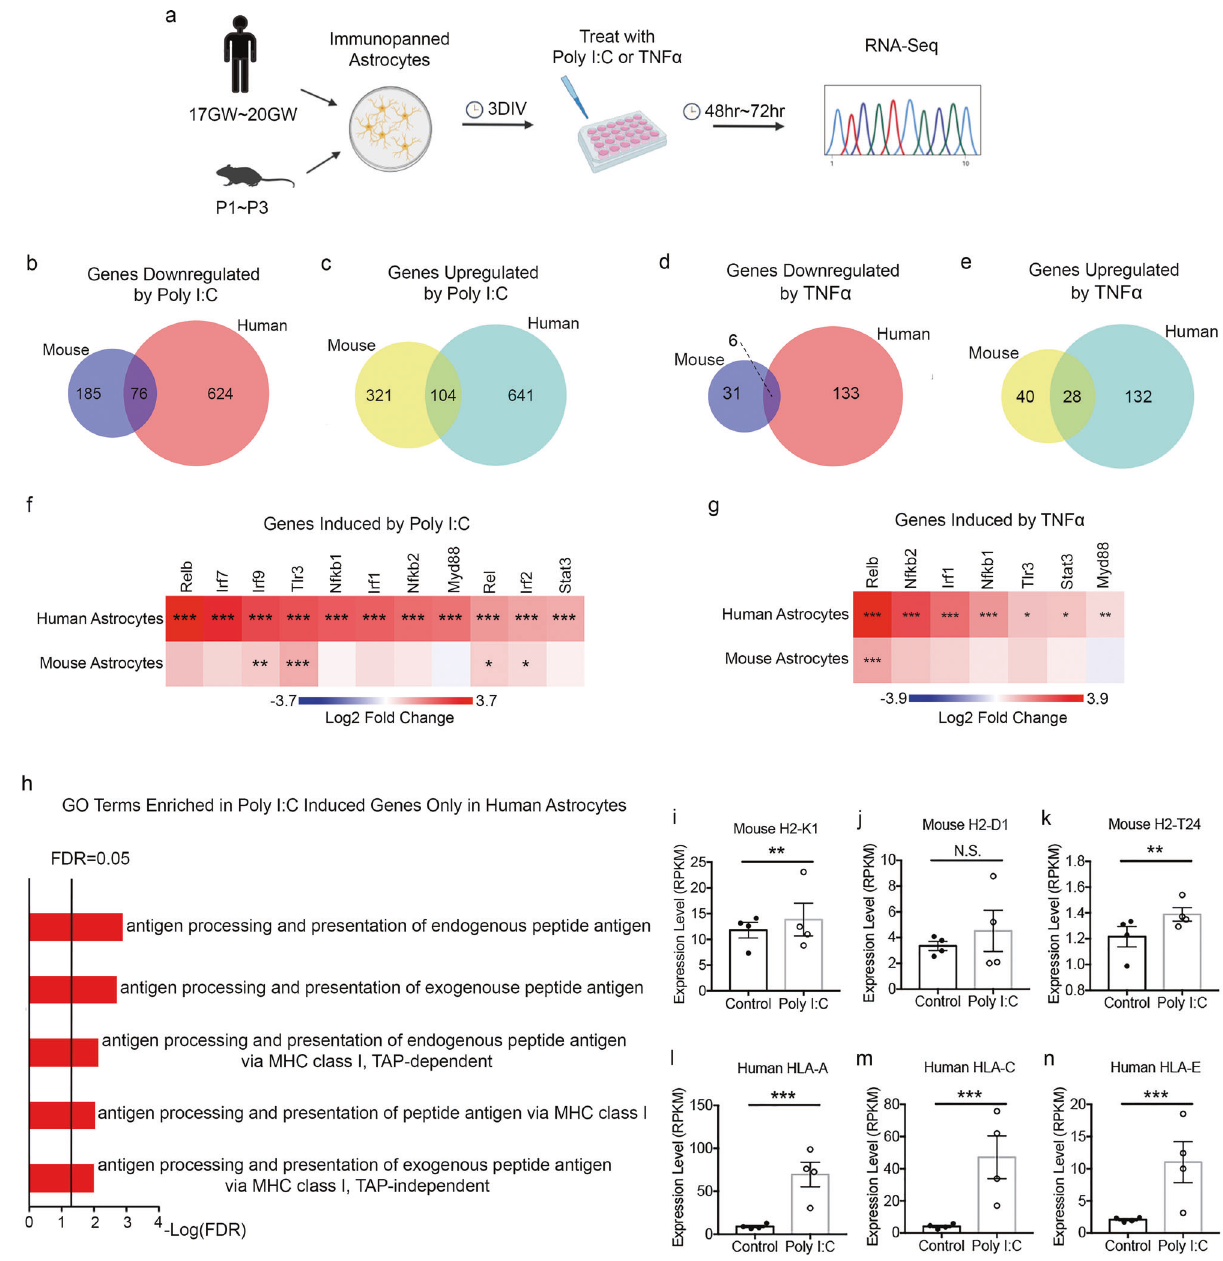
Fig. 7 Molecular responses of human and mouse astrocytes to poly I:C and TNF α . a Experimental design. b – e The number of signi fi cantly up or downregulated genes in poly I:C- and TNF α -treated human and mouse astrocytes. Genes with FDR < 0.05, fold change > 1.5, and average RPKM of control or treated groups > 1 are shown. f , g Fold changes of Tlr3, NF κ B , and interferon response pathway genes in poly I:C- and TNF α -treated human and mouse astrocytes. Asterisks represent signi fi cance determined by DESeq2. h Selected antigen presentation-related GO terms enriched in poly I:C-induced genes only in human astrocytes. i – n Expression of the top 3 highest-expressing MHC Class I antigen presentation genes in poly I:C-treated and control human and mouse astrocytes. N = 4 litters of mice and 4 human patients. Mouse: H2-K1, p = 0.0051; H2-T24, p = 0.0019. Human: HLA-A, p < 0.0001; HLA-C, p < 0.0001; HLA-E, p < 0.0001. Multiple comparison-adjusted p values were calculated by the DESeq2 package. N.S., not signi fi hypoxia, we found that both poly I:C and TNF α induced stronger mouse astrocytes and a signi fi cant proportion (14.0%; 104 out of molecular responses in human astrocytes relative to mouse 745) of upregulated genes in human astrocytes were also astrocytes in terms of the number of differentially expressed genes upregulated in mouse astrocytes under poly I:C treatment (Fig. 7b, c; (Fig. 7b-e and Supplementary Fig. 17a, b, d, e) and effect size upregulated: 1.7-fold higher than expected by chance; p = 2.79e − 07; (Supplementary Fig. 17c, f). We next examined the extent to downregulated: 2.2-fold; p = 4.89e − 12). A signi fi cant proportion which the poly I:C- and TNF α -induced gene changes were shared (4.3%; 6 out of 139) of genes downregulated by TNF α in human between human and mouse astrocytes. We found that a astrocytes were also downregulated in mouse astrocytes and a signi fi cant proportion (10.9%; 76 out of 700) of the down- signi fi cant proportion (17.5%; 28 out of 160) genes upregulated by regulated genes in human astrocytes were also downregulated in TNF α in human astrocytes were also upregulated in mouse astrocytes,